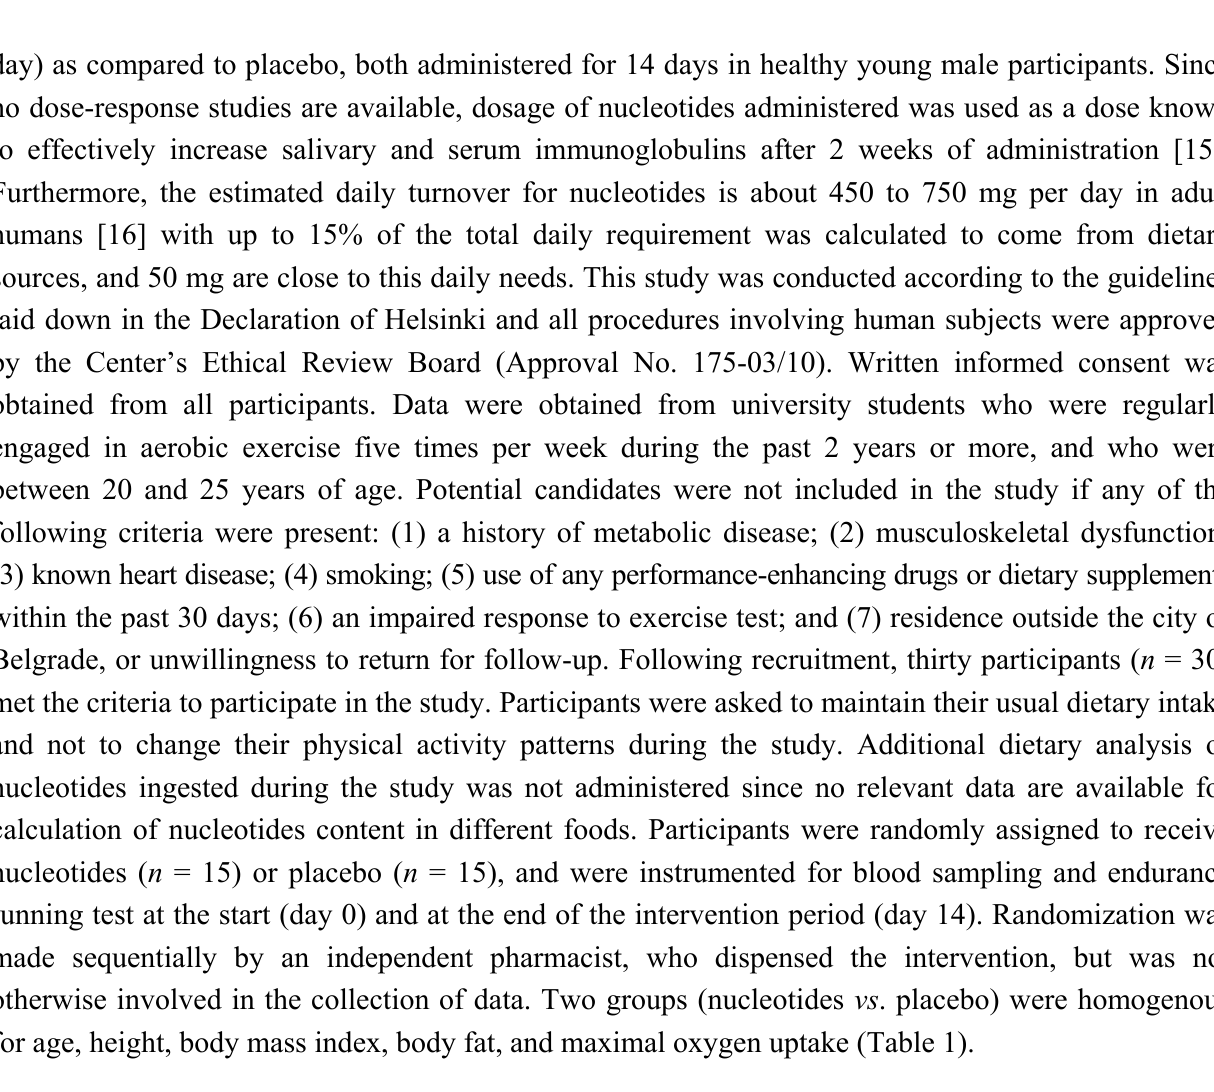
Table 1. Characteristics of the participants (mean ±